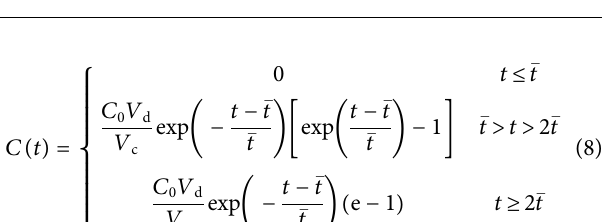
FIGURE 7 | Physical model of fracture series cavity in one injection-production